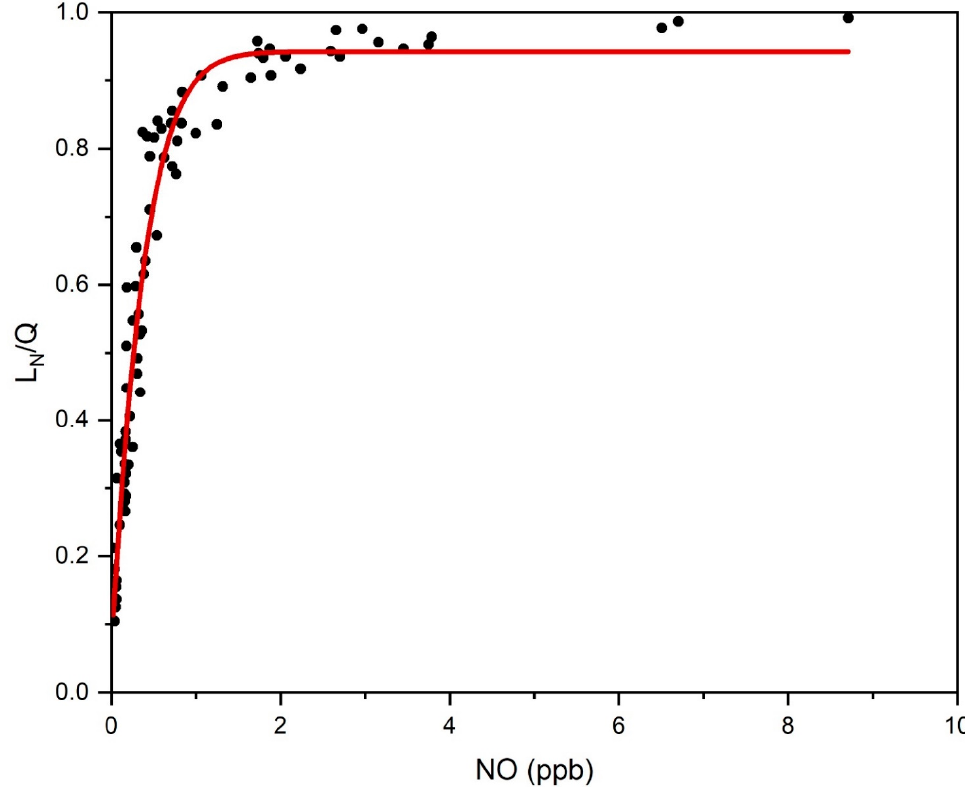
Figure 4. Relationships between (cid:2896) (cid:3146) and [NO] during this field campaign. Most of the variations in (cid:2896) (cid:3146) relied on the changes in [NO], especially when [NO] decreased to less than 0.2 ppb.